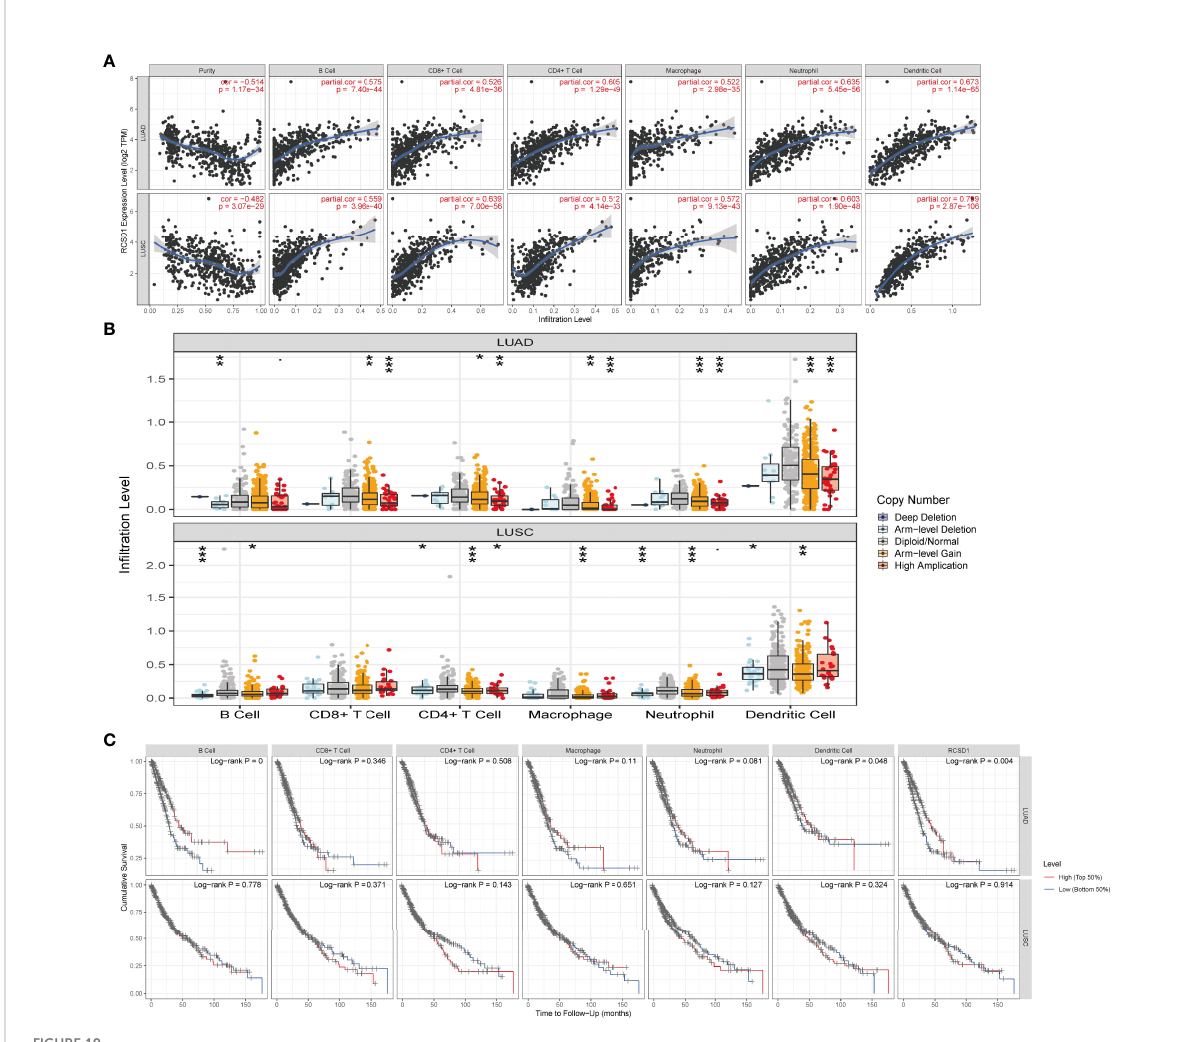
FIGURE 10 Correlation of RCSD1 expression and immune in fi ltration level. (A) Correlation of RCSD1 with tumor purity and in fi ltration of different immune cells. (B) The in fi ltration level of each immune subset at different copy numbers of RCSD1 in LUAD and LUSC. (C) Effects of multiple tumor immune subsets and RCSD1 expression on the prognosis of LUAD and LUSC patients. *, P<0.05; **, P<0.01; ***,